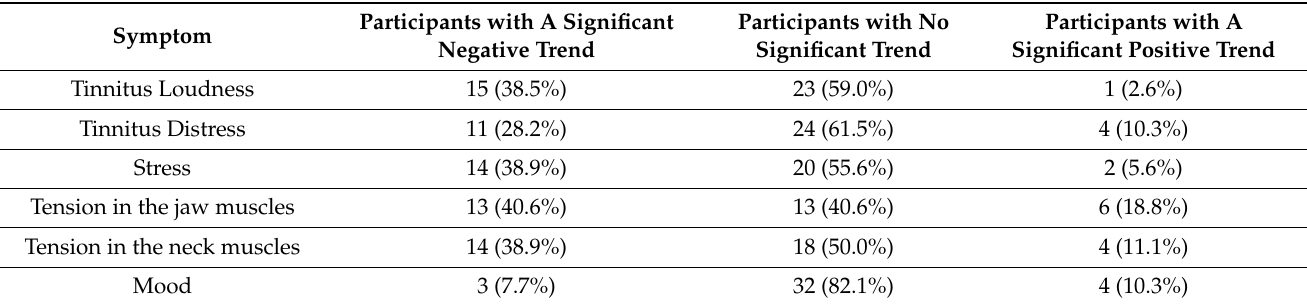
Table 4. Overview of the slope estimates in the linear trend analyses.